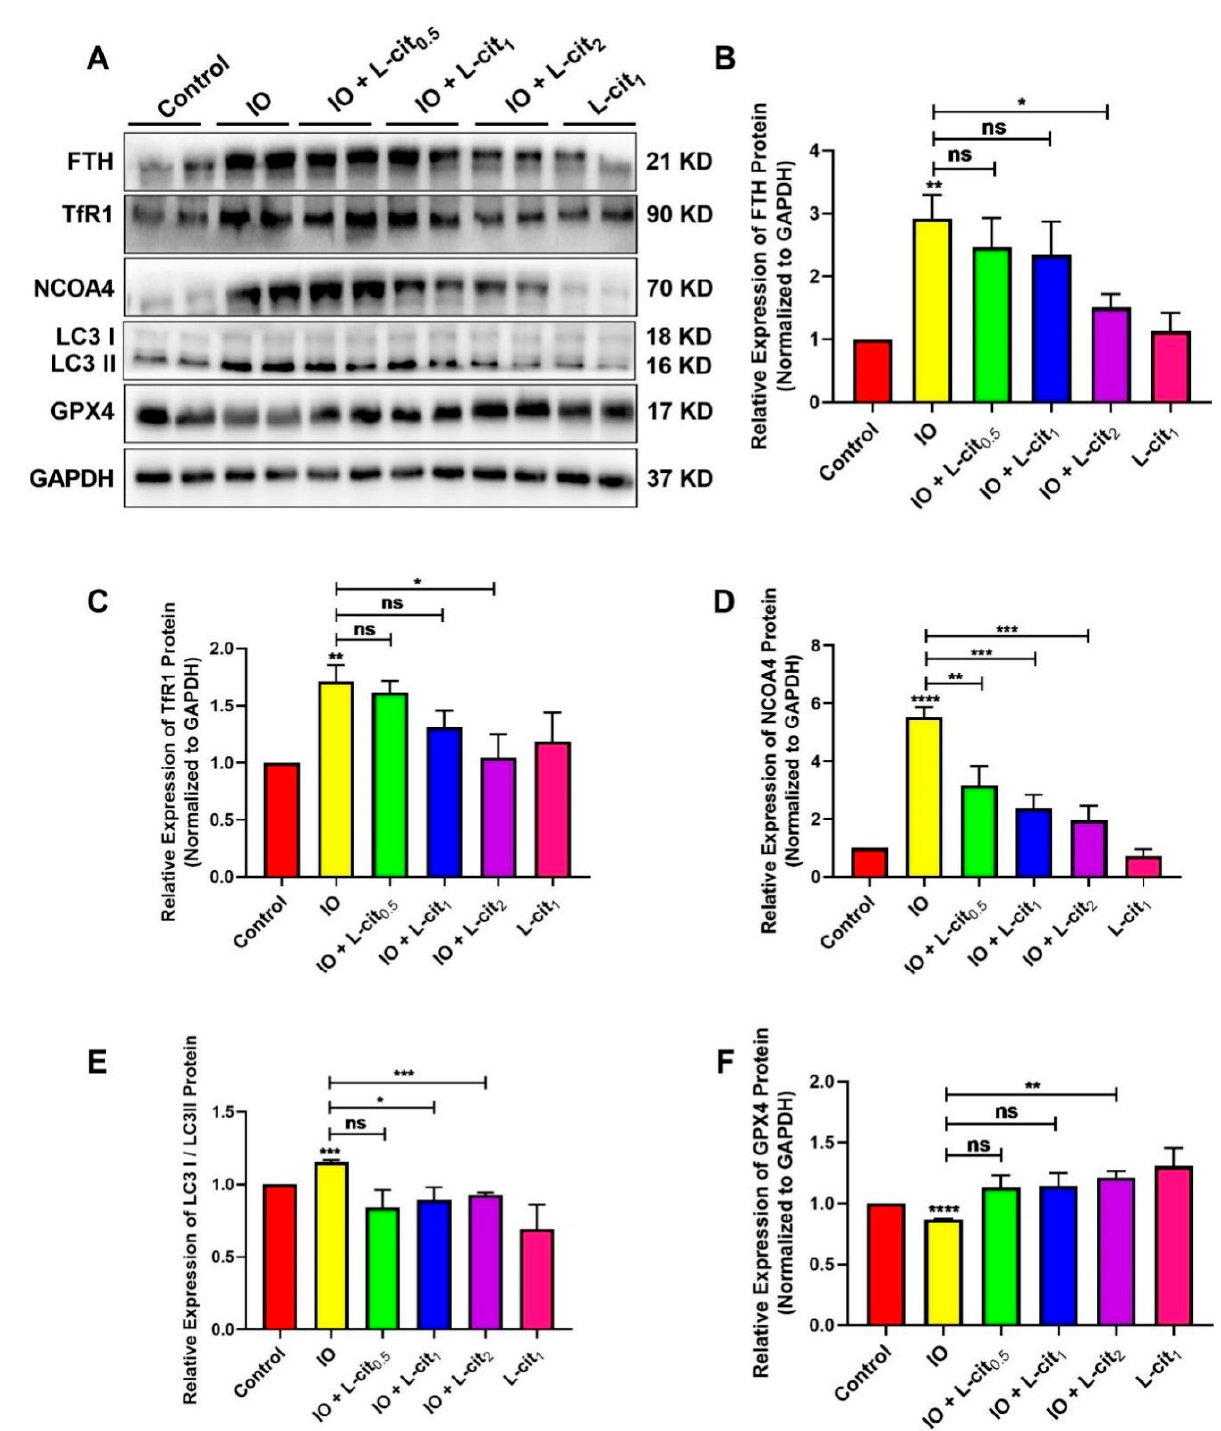
Figure 3. L-cit restrains ferritinophagy induced by iron overload in mouse thymus. Mice were intraperitoneally injected with iron dextran 50 mg/kg, and L-cit was given by gavage administration with a dosage of 0.5, 1.0, and 2.0 g/kg/day. Immunoblot analyses were explored. ( A , B ) Immunoblot analyses of FTH. ( A , C ) Immunoblot analyses of TfR1. ( A , D ) Immunoblot analyses of NCOA4. ( A , E ) Immunoblot analyses of LC3. ( A , F ) Immunoblot analyses of GPX4. GAPDH was used as the loading control. Values represent mean ± SEM. of three independent experiments. Significant differences are represented by * p < 0.05, ** p < 0.01, *** p < 0.001, **** p < 0.0001, ns (not significant).